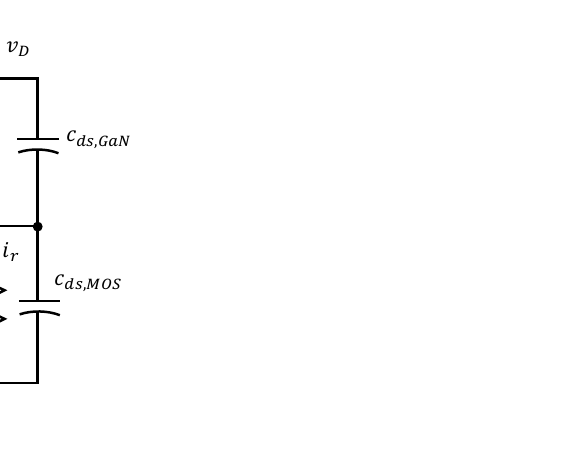
Figure 8. Charge pump response of GaN-switching cascode GaN HEMT power module. The source terminal of the power module is connected to the ground and v S = 0